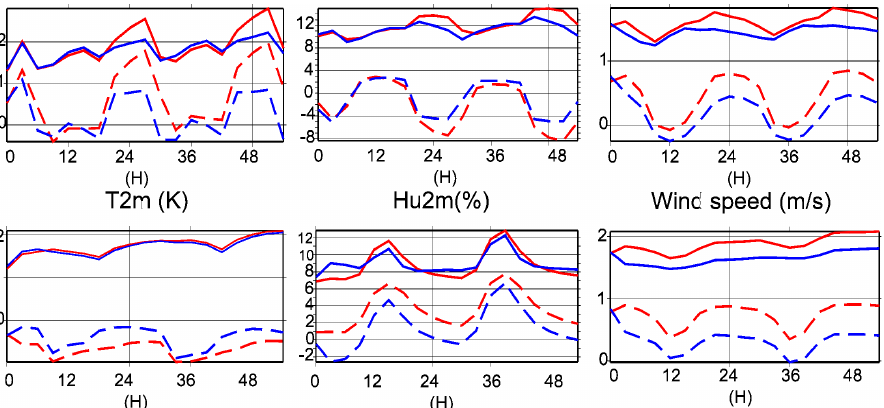
Fig. 7. Evaluation of SURFEX within the ALADIN/France configuration for a summer period (June–September 2010) (top) and a winter period (December 2010–March 2011) (bottom). Biases (dashed lines) and rms (continuous lines) as a function of the forecast lead time are presented for the ALADIN without SURFEX (in red) and with SURFEX (in blue). Left: 2m temperature (K), centre: 2m humidity (%), right: 10m wind speed (ms − 1